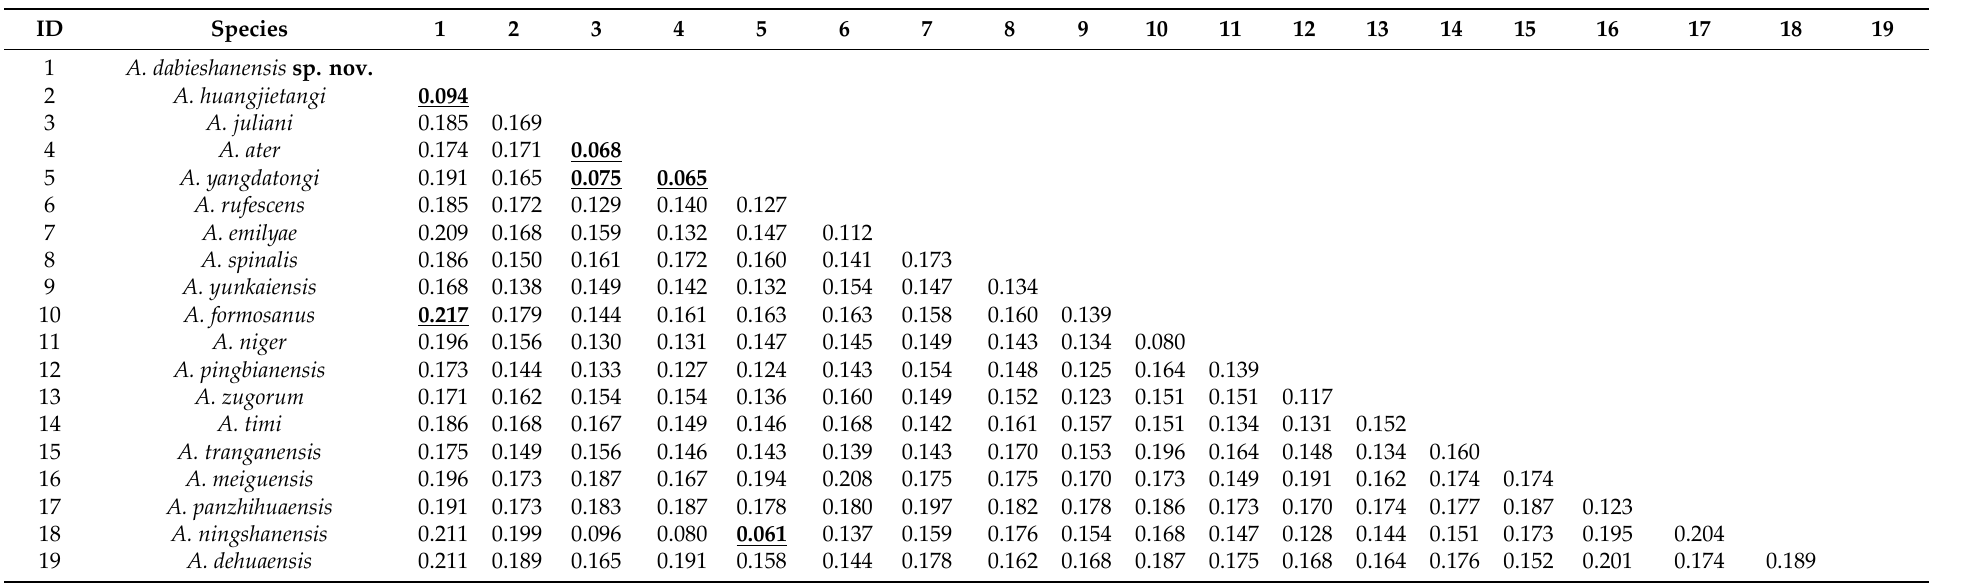
Table 2. Uncorrected p ‑distances among the Achalinus species based on partial mitochondria COI